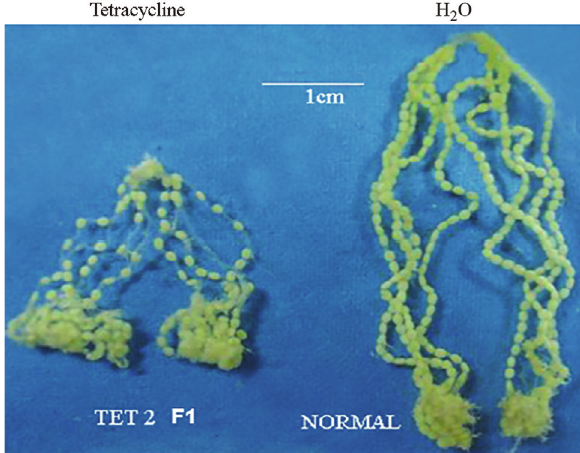
Figure 7 - Ovary phenotype of F1 generation females after tetracycline treatment. The injected H 2 O group was used as control. Tetracycline was injected with a lower dose of 0.1 mg per silkworm. After antibiotic treat- ments, tetracycline-injected females were crossed with tetracycline- injected males. The F1 generation was reared and used to identify the ovary phenotype. Nearly 29% of the F1 female still showed an abnormal ovary